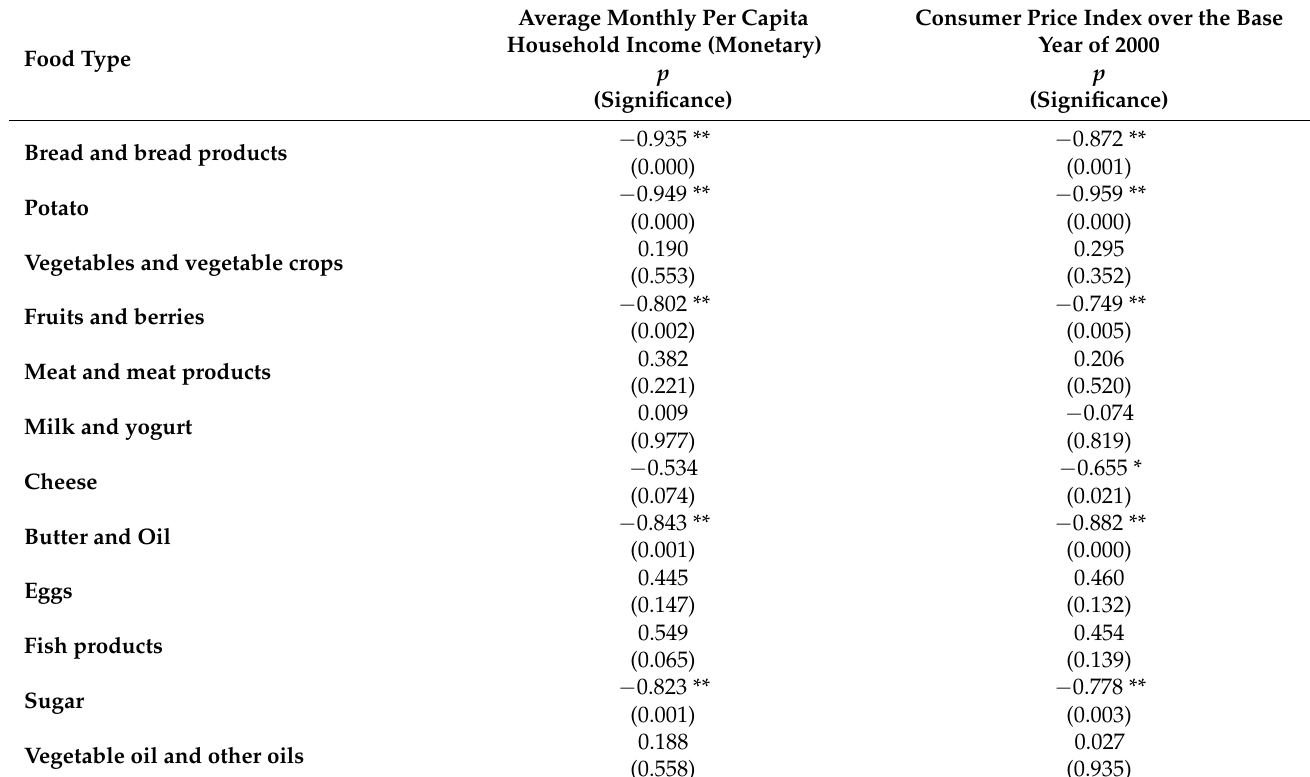
Table 3. Pearson Correlation between food consumption, income, and CPI. Armenia.